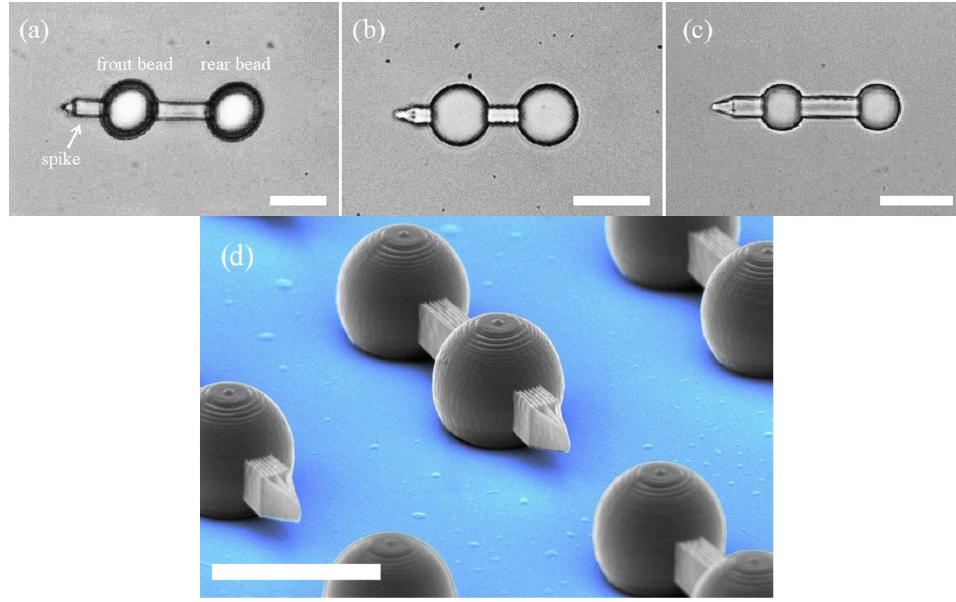
Figure 2. Optical microscope images of three micro-tool designs with different bead diameters Ø and total lengths L; ( a ) Ø = 10 µm, L = 37 µm; ( b ) Ø = 8 µm, L = 25 µm; ( c ) Ø = 6 µm, L = 26 µm. ( d ) Scanning electron microscope (SEM) image of the micro-tools on the glass substrate (with computer-added colors) shows the limits in resolution of the 3D laser photolithography. Scale bars: 10 µm.